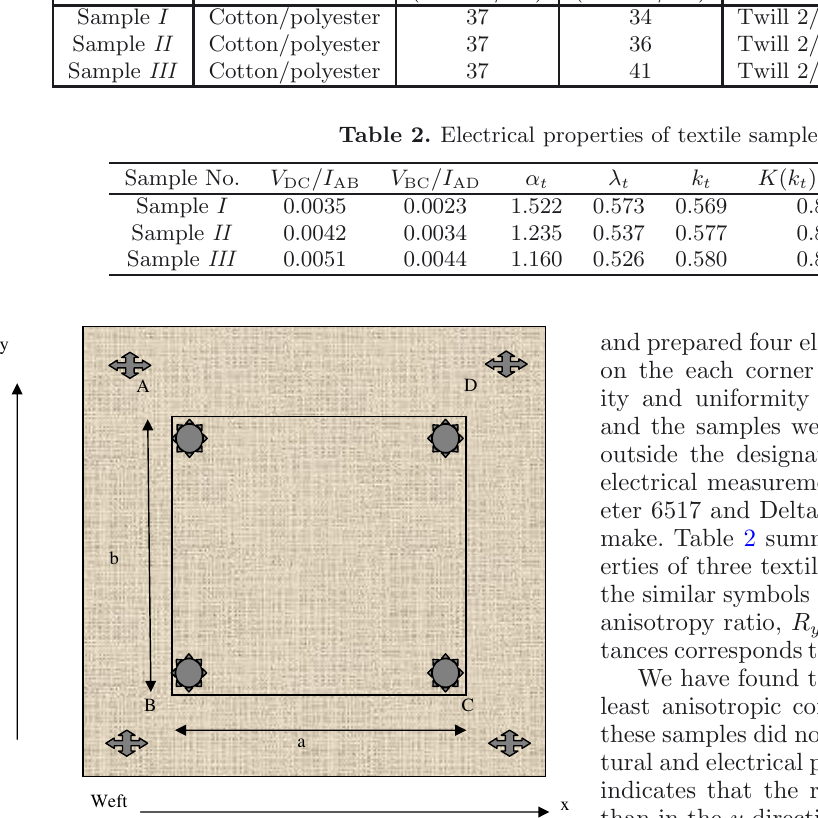
Fig. 1. Arrangement of a textile for structural and electrical